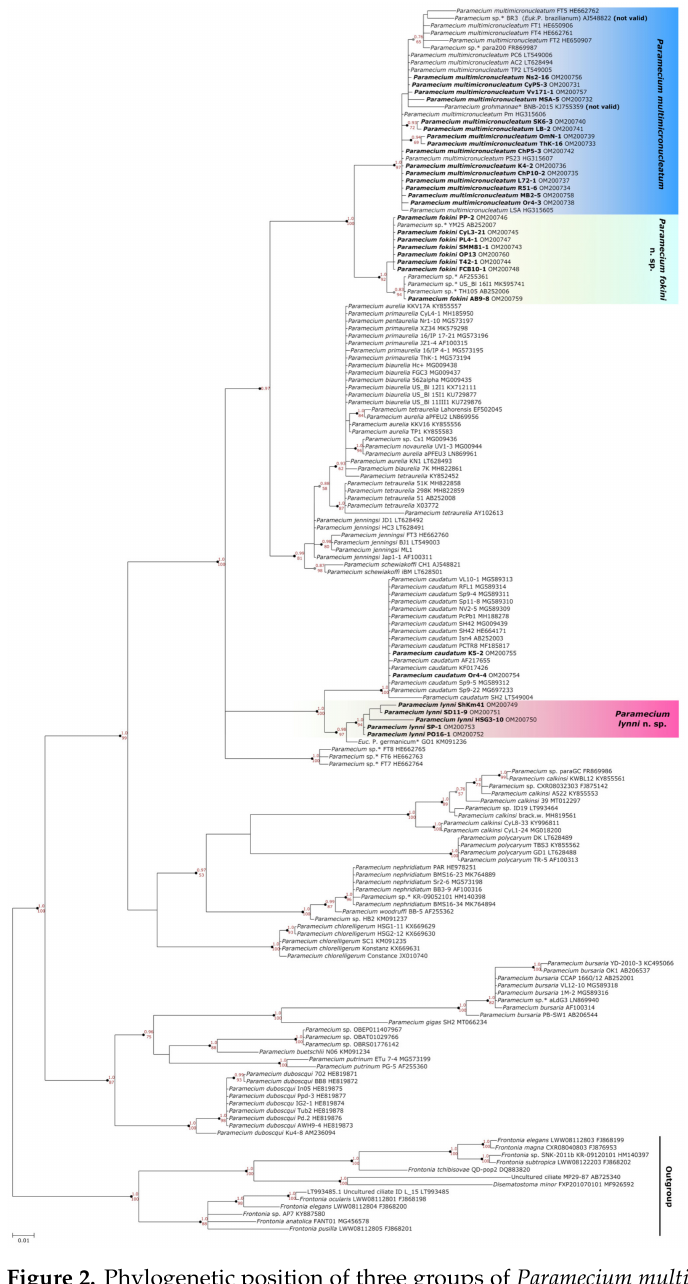
Figure 2. Phylogenetic position of three groups of Paramecium multimicronucleatum -like strains on the 18S rRNA gene tree. Numbers associated with the nodes represent a posterior probability from Bayesian inference (BI) and the bootstrap value from maximum likelihood (ML) analyses. Strains marked in bold were analyzed in this study. Asterisks (*) indicate the misidentified or non-identified at the species level strains in NCBI (see Table